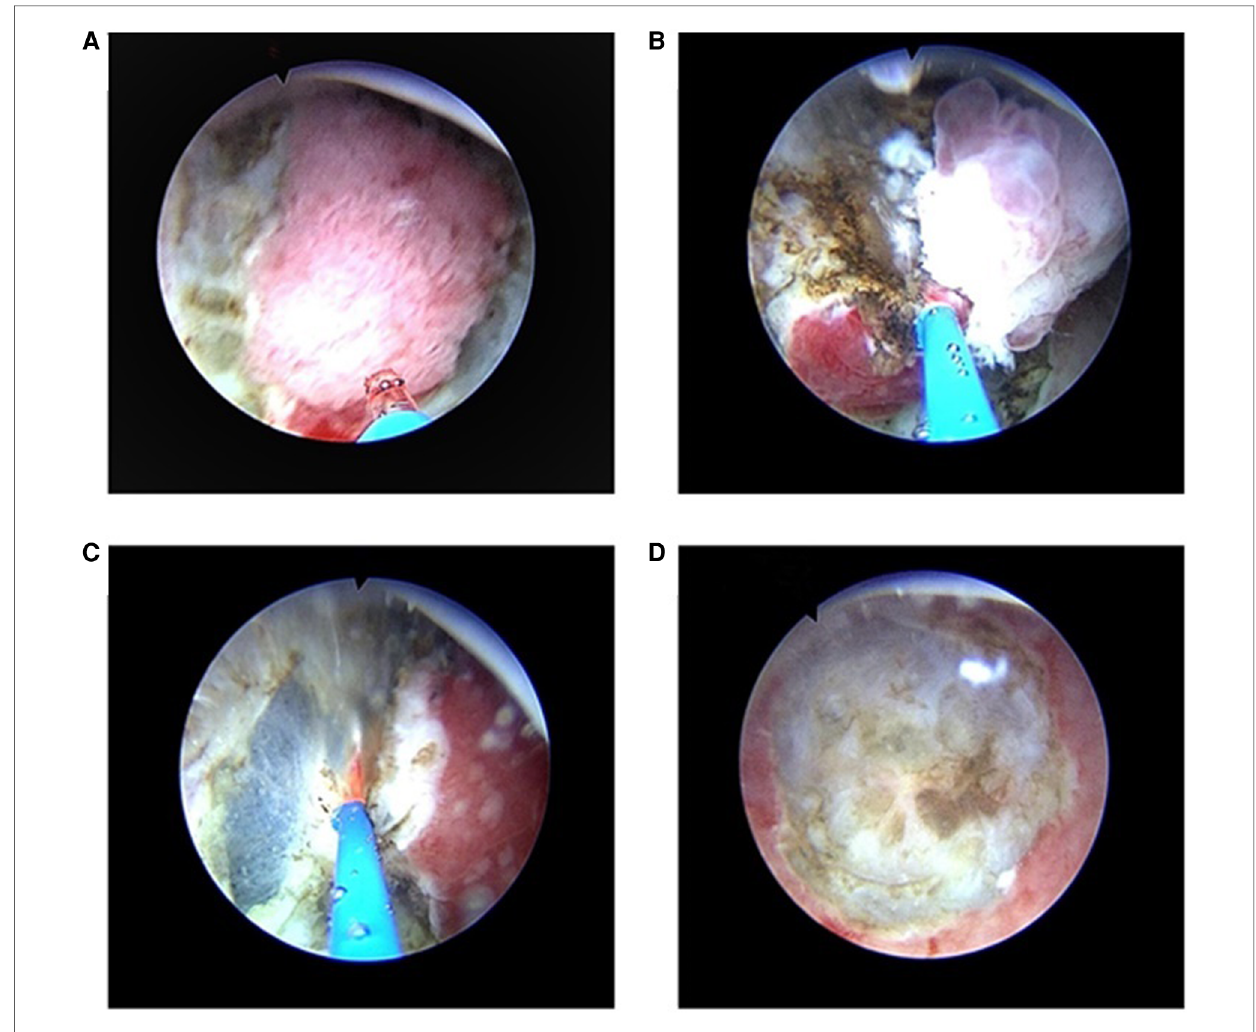
FIGURE 1 TURBT with a 2-micrometer continuous-wave laser for NIMBC ( A ) First, the normal mucosa and submucosa about 0.5-cm – 1.0-cm away from the tumor were vaporized and incised. ( B ) If the tumor was large, the super fi cial tumors were segmentally removed, and then the whole muscle layers at the tumor base were peeled in a layered and segmented manner. ( C,D ) If the tumor was small, the muscular and serosal layers at the tumor base were directly removed, and the tumor, basal part, and part of the muscle layer underwent en bloc